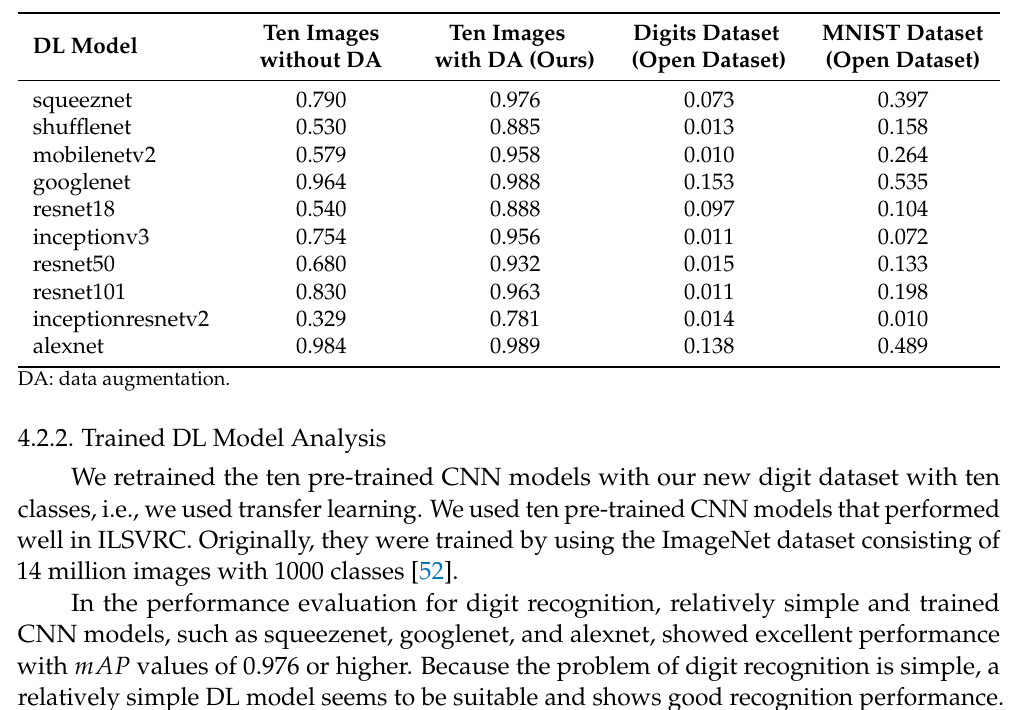
Table 4. Recognition performance ( mAP ) evaluation for training DL models depending on the